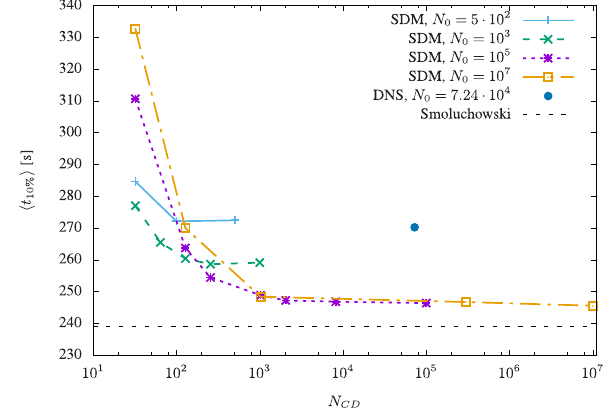
Figure 4. Mean t 10% for different cell sizes and different numbers of computational droplets N CD . In SDM simulations, N CD = N SD , and in DNS, N CD = N 0 . The single DNS result is taken from Onishi et al. (2015) (the NoT-HI case therein). Ensemble sizes are (cid:127) ≥ 10 3 for SDM simulations and (cid:127) = 10 2 for DNS. The 95% confidence intervals are smaller than the plotted points. The rightmost point in each SDM series comes from the “one-to-one” simulations. Other points in SDM series come from the “constant SD” simulations with various values of N SD . The horizontal line is a value obtained by nu- merically solving the Smoluchowski equation using the flux method from Bott